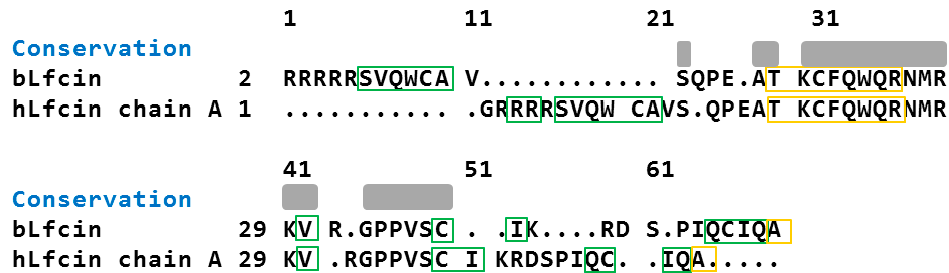
Figure 2. Comparison of bovine and human Lfcin moiety. Upper gray box represents amino acid identity. Green boxes represents beta sheet and yellow box represent alfa sheet structure homology.